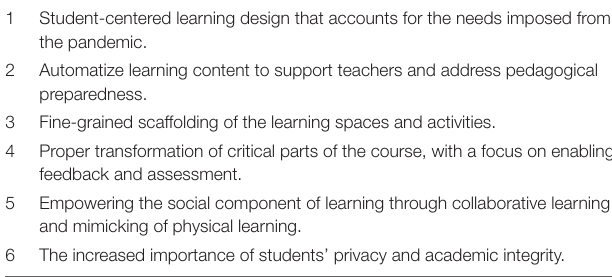
TABLE 2 | Lessons